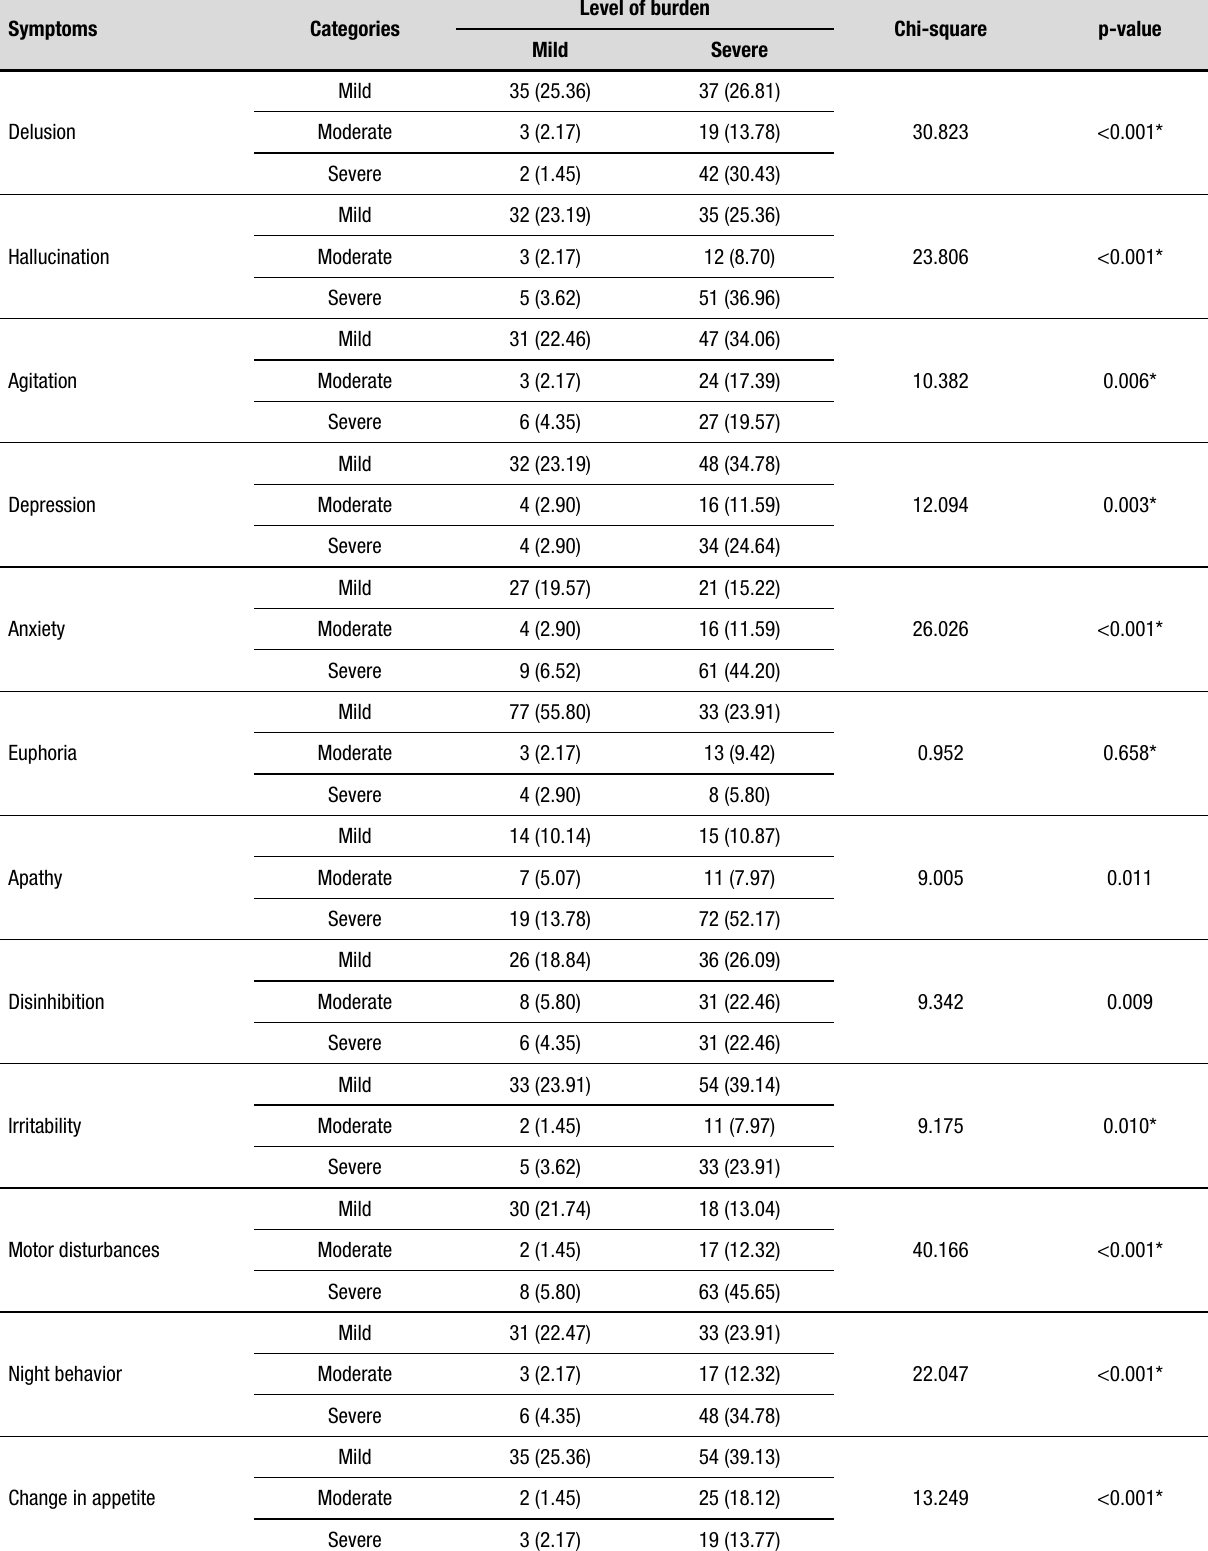
Table 2. Association between care-recipients’ neuropsychological symptoms and caregivers’